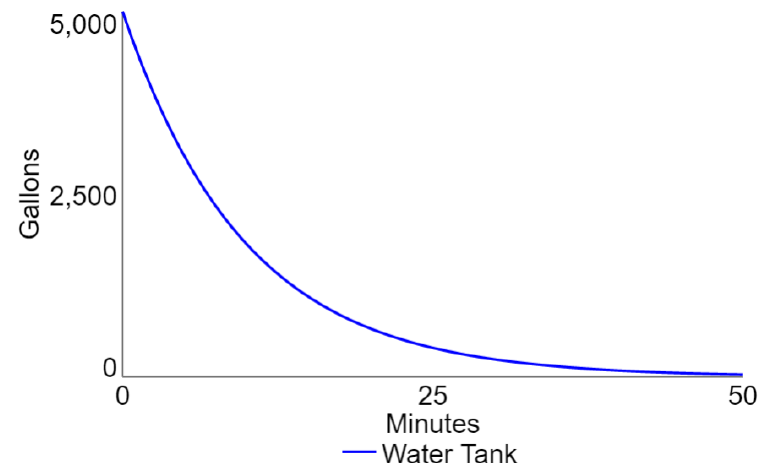
Fig. 10. Tank volume vs